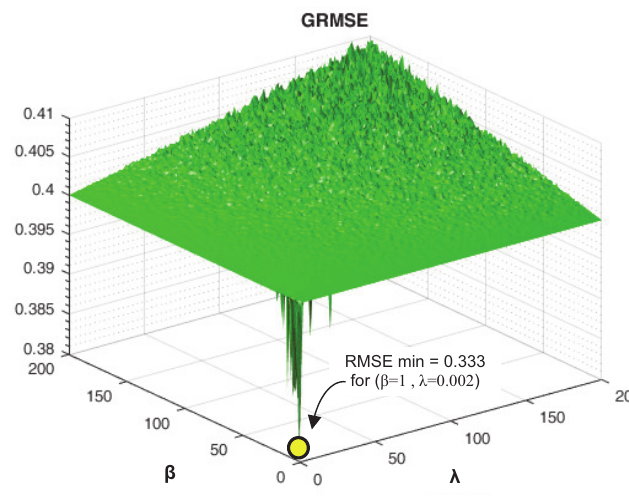
Figure 4. Example of a direct search of the minimum RSME corresponding with the best pair ( β , λ